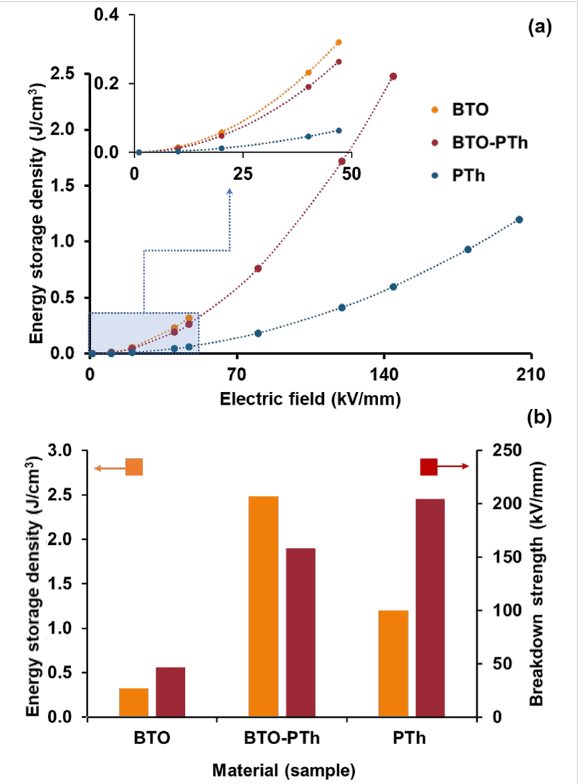
Figure 7: A plot of energy storage density as a function of the electric field strength (a), and the calculated maximum energy storage density and electrical breakdown strength (b) of the different dielectric materi-